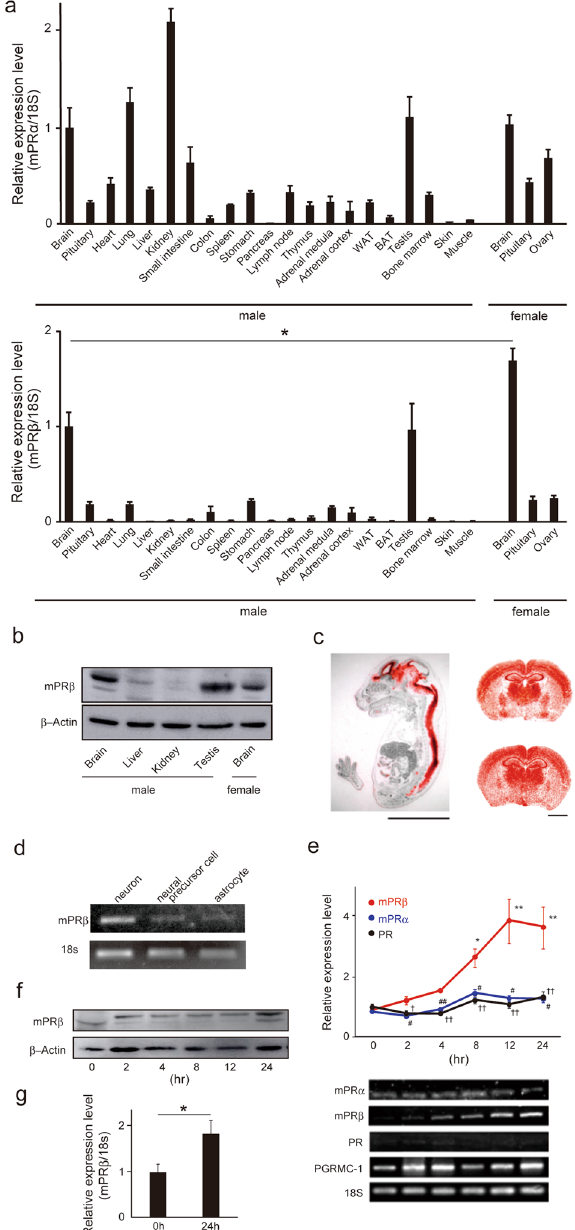
Figure 1. mPR β is specifically expressed in the brain. ( a ) Expression of mPR α and mPR β mRNA in mouse tissues (Post-natal day 49: P49) measured by quantitative RT-PCR (n = 3). WAT: White adipose tissue (epididymal adipose tissue), BAT: Brown adipose tissue. Control: 18S mRNA expression. Statistical analysis was performed by using Student’s t-test. ( b ) Expression of mPR β protein in mouse tissues (Post-natal day 49: P49) measured by western blotting. β -actin protein expression was used as an internal control. ( c ) Localization of mPR β mRNA in mouse embryos (E15.5, sagittal sections, Scale bar = 5 mm) and mouse brain (upper: male, lower: female, P49, coronal sections, Scale bar = 2 mm). They were examined by in situ hybridization with a 35 S-labeled antisense mouse mPR β RNA probe. Red grains superimposed on a hematoxylin-eosin stain indicate the localization of mPR β mRNA. ( d ) mPR β cDNA (about 600 base pairs) was detected in neurons, neural precursor cells, and astrocytes by 1.5% agarose gel electrophoresis followed by staining with ethidium bromide. 18S mRNA expression was used as an internal control. ( e ) The expression of the progesterone receptor was examined by quantitative RT-PCR in NGF-induced neuronal PC12 cells. (n = 3–6). * p < 0.05, and ** p < 0.01, compared with 0 h mPR β ; # p < 0.05, and ## p < 0.01, compared with mPR β ; † p < 0.05, and †† p < 0.01, compared with mPR β (Tukey-Kramer). PR: Progesterone Receptor. ( f ) mPRb protein expression in NGF-induced neuronal PC12 cells. β -actin protein expression was used as an internal control. ( g ) Expression of mPR β mRNA in NGF-induced neuronal SH-SY5Y cells. Statistical analysis was performed by using Student’s t-test. Results are presented as means ± S.E.M. * p <